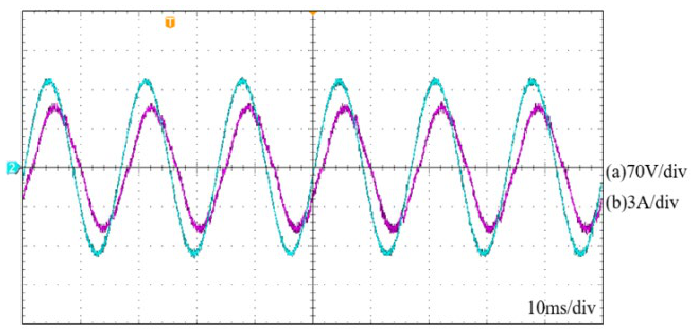
Figure 14. Experimental results of BBI for supplying lagging current, ( a ) power grid voltage, ( b ) output current.